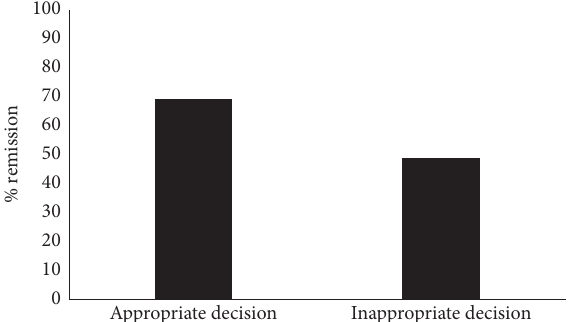
Figure 4: Remission at 6 months separated by clinical decision following infliximab therapeutic drug monitoring in inflammatory bowel disease patients with concerns for loss of